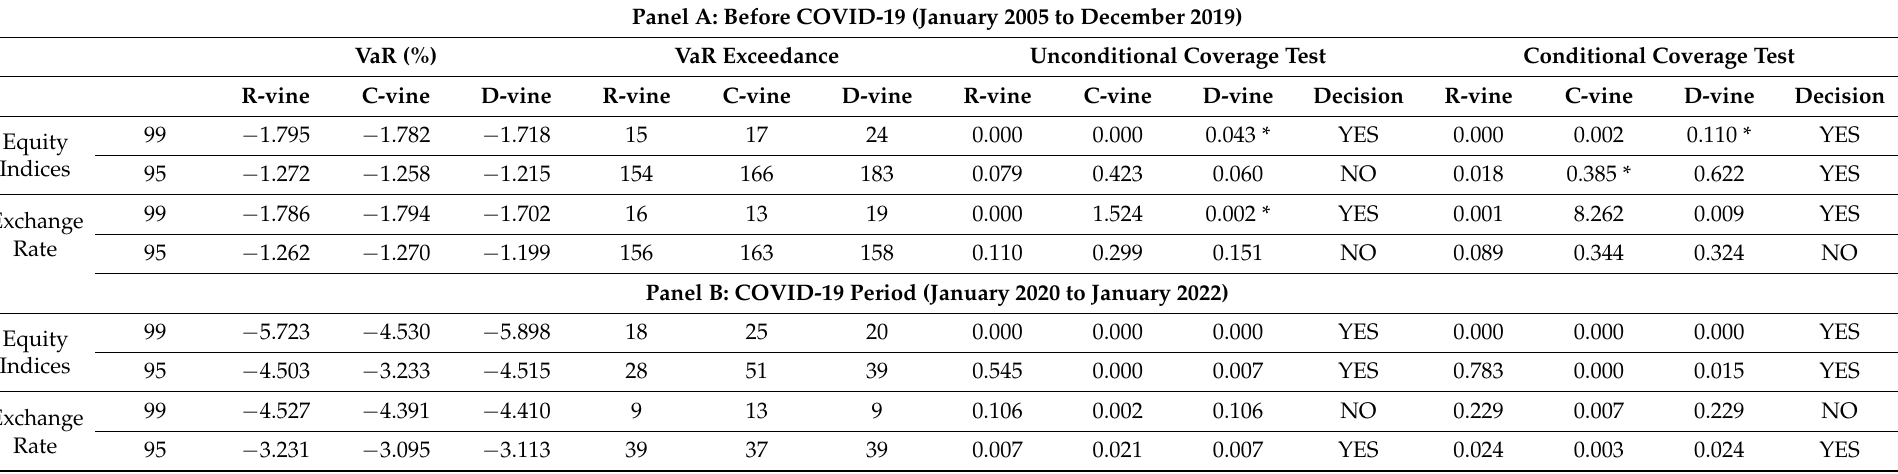
Table 5. Assessment of the dynamic properties of the joint distribution-VaR